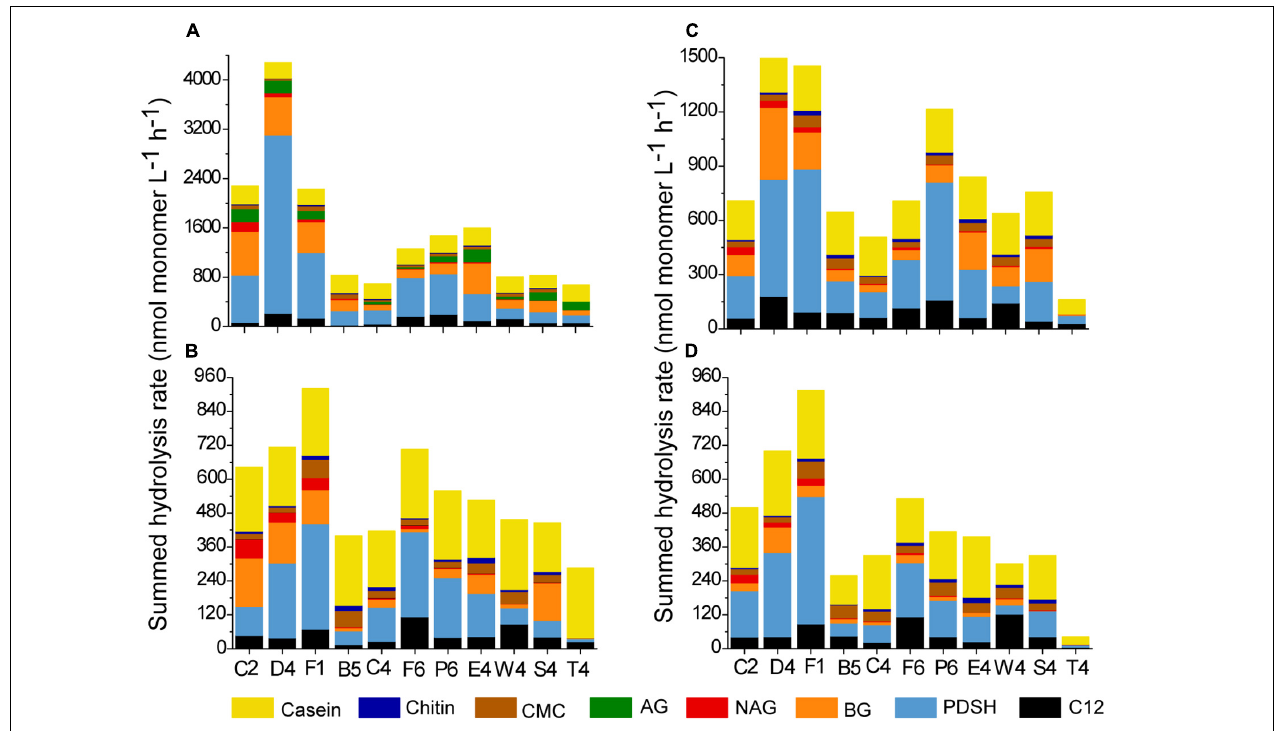
FIGURE 4 | Summed hydrolysis rates at each station. (A) The unfiltered waters at 35 ◦ C. (B) The 0.22- µ m filtered waters at 35 ◦ C. (C) The unfiltered waters at 25 ◦ C. (D) The 0.22- µ m filtered waters at 25 ◦